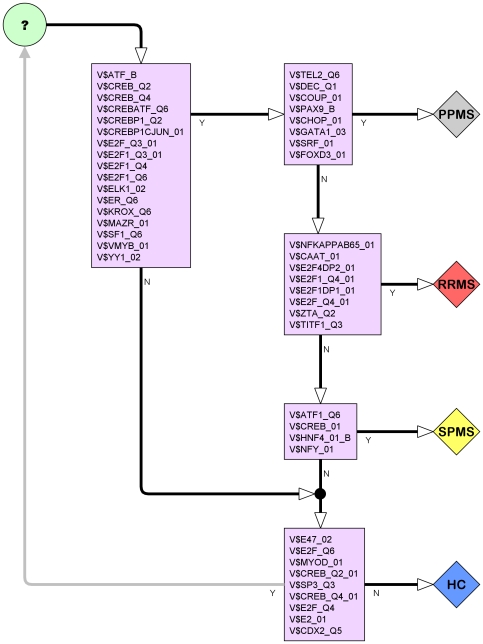
Speculative initial sketch for a model of transcription factors currently known to be involved in T cell specification and which may also be involved in the pathogenesis of MS, showing links to disease subtype.Other transcription factors that also need to be added to this model are those which we have found very relevant in our analysis such as the Early Growth response EGR/KROX family, ATF2, YY1 (Yin and Yang 1), E2F-1/DP-1 and E2F-4/DP-2 heterodimers, SOX5, and CREB and ATF families.